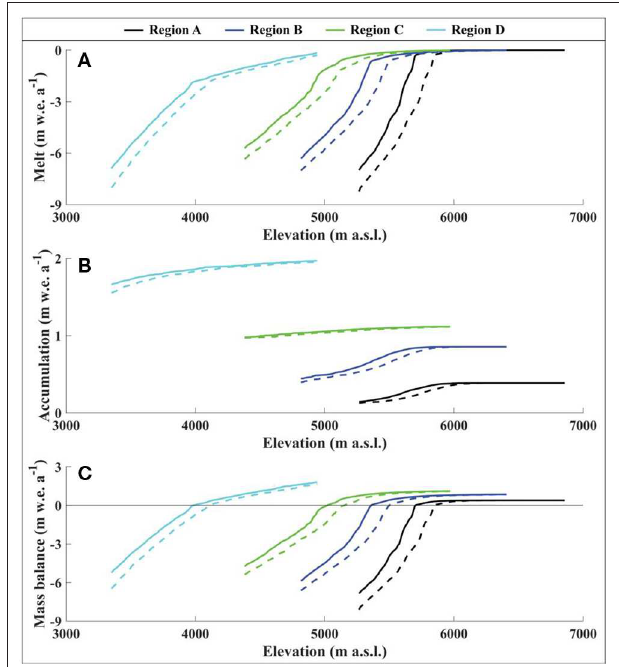
FIGURE 10 | Summary of glacier melt (A) , accumulation (B) , and mass balance (C) for each region with no temperature change (solid lines) and with a + 1 ◦ C temperature change (dashed lines). Values are averaged over 10m elevation bands across the glacier